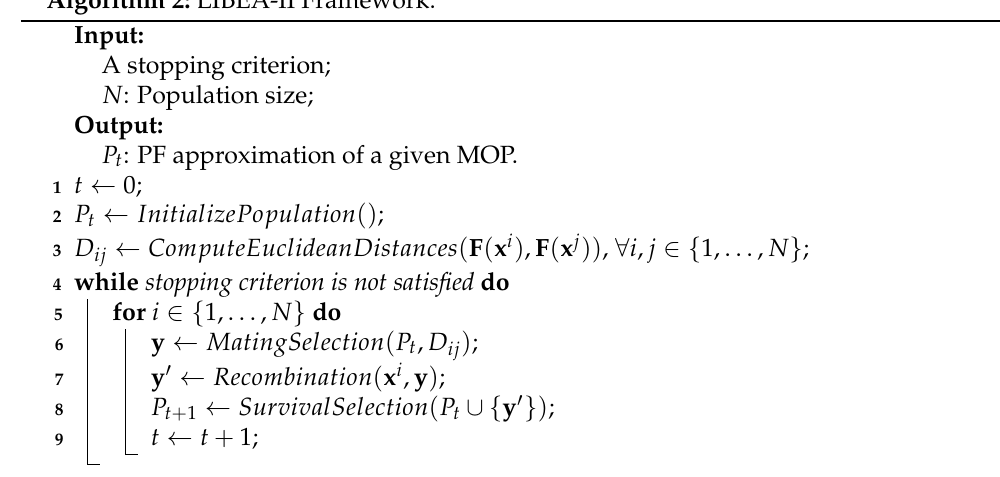
Algorithm 2: LIBEA-II